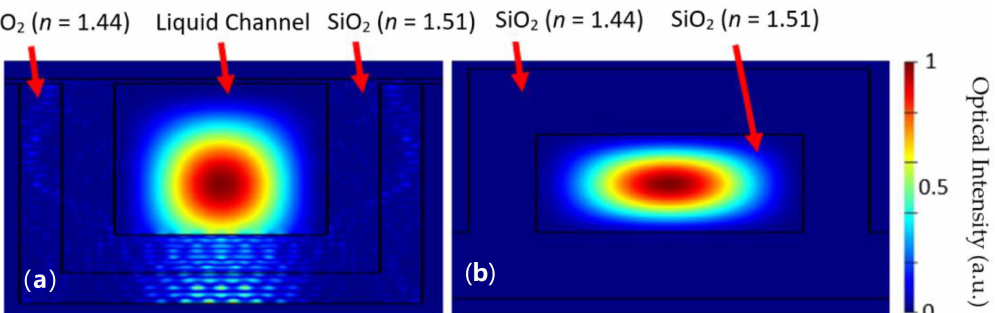
Figure 4. E field intensity zero order mode profile of the liquid channel ( a ) and ridge waveguide ( b ) using Lumerical FDE with a 532 nm